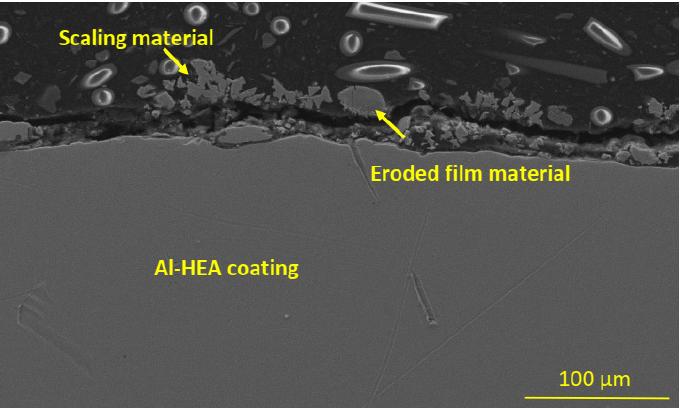
Figure 19. Eroded, detached AL-HEA material was observed at the surface in the sample AL-HEA- SS in the erosion